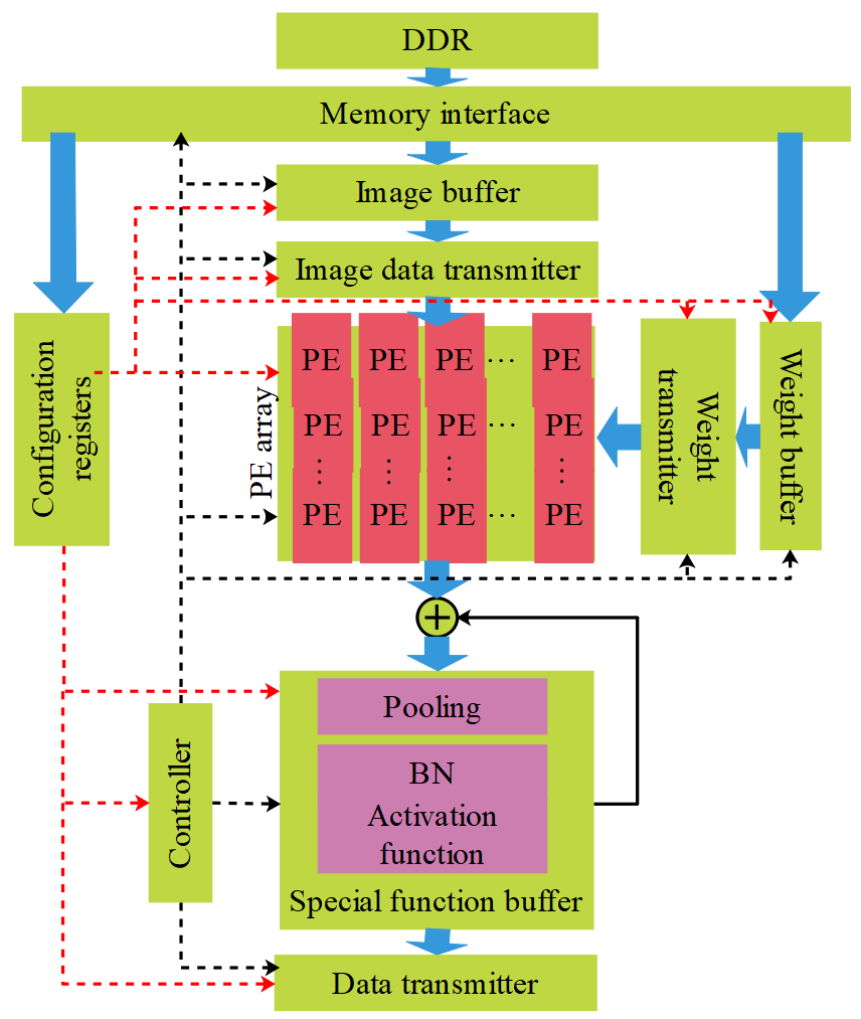
Figure 1. Data-flow-based reconfigurable architecture.